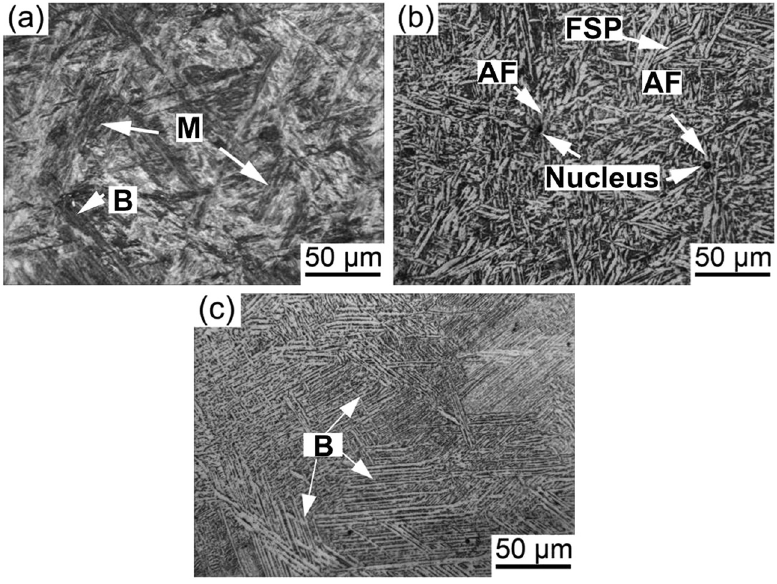
Figure 1: Microstructures of the three steels quenched from 1,100°C. ( a ) Steel no. 1, ( b ) steel no. 2, and ( c ) steel no. 3.